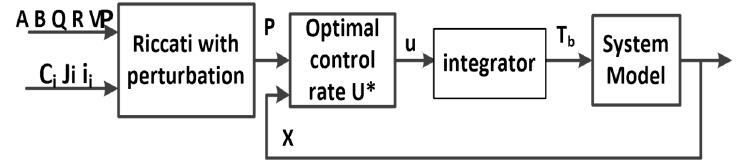
Figure 6. Block diagram of an optimal controller for torque.